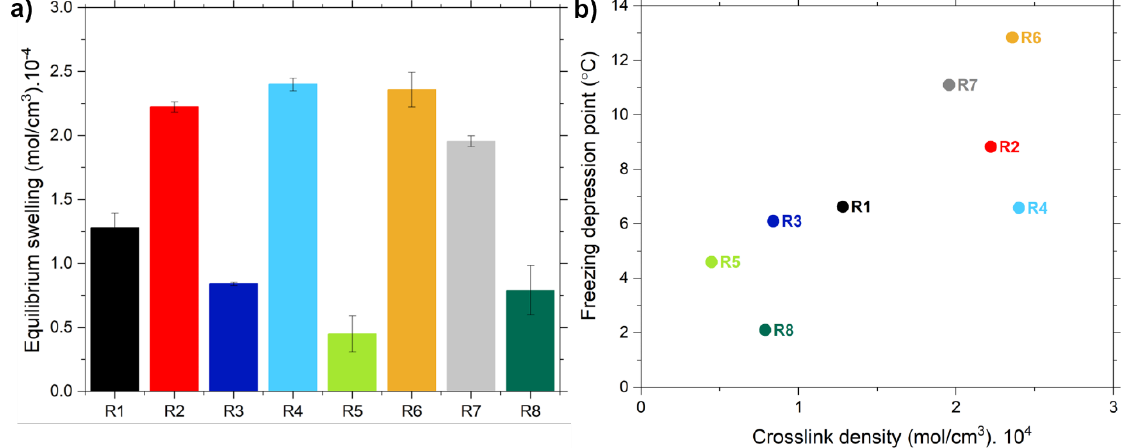
Figure 7. ( a ) Crosslink density measured by equilibrium swelling and ( b ) correlation between the crosslink density results obtained by freezing point depression and equilibrium swelling.